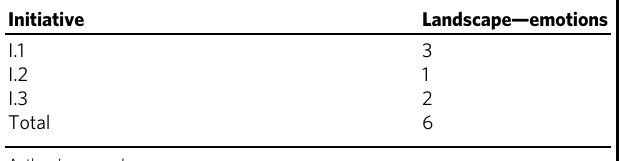
Table 16 Type of perspective of landscape for each initiative.